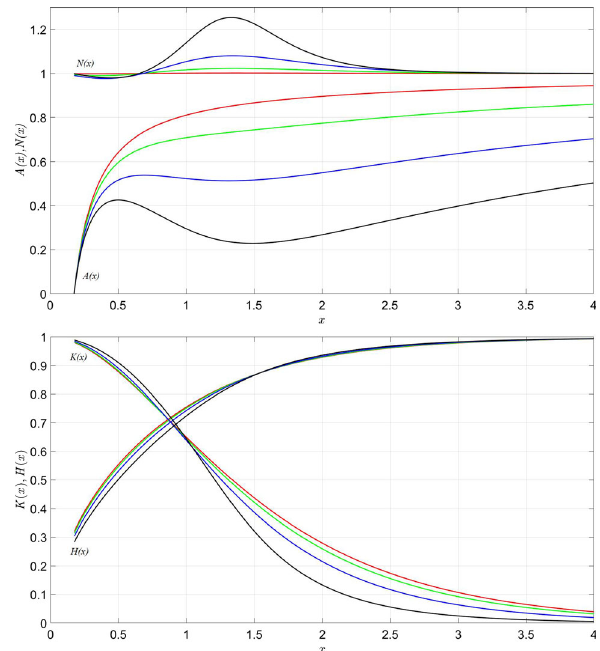
Fig. 8 Plot of function A ( x ), N ( x ) versus x (top) and K ( x ), H ( x ) versus x (bottom) of the EWS magnetically charged black hole for α = 0 . 2 (red), 0 . 6 (green), 1 . 0 (blue) and 1 . 4 (black) at fixed horizon radius x H = 0 .